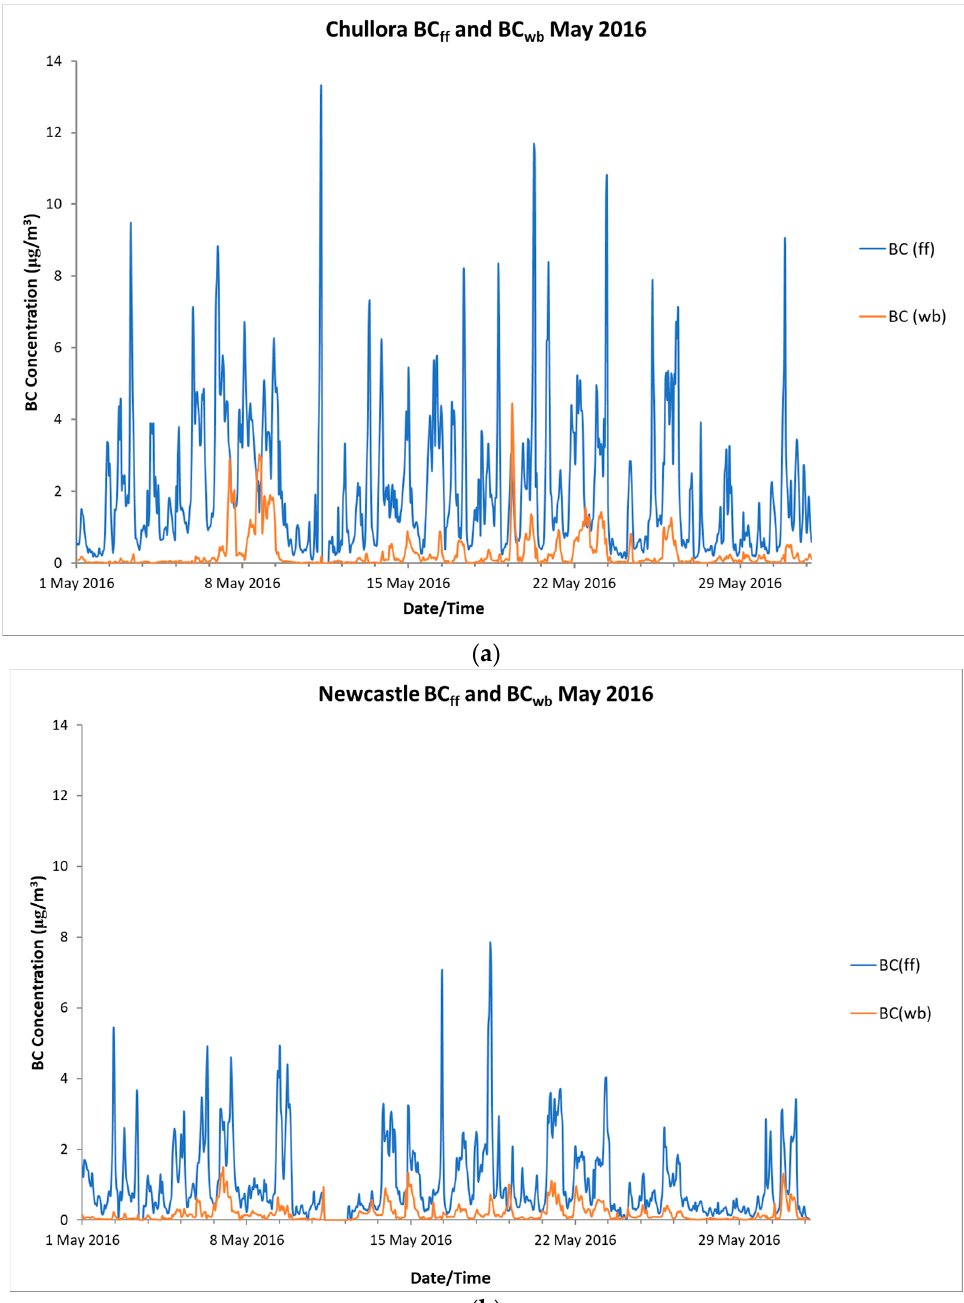
Figure 13. BC from fossil fuel combustion (BC ff ) and from biomass burnings (BC wb ) for May 2016: ( a ) at Chullora; and ( b ) at Newcastle.